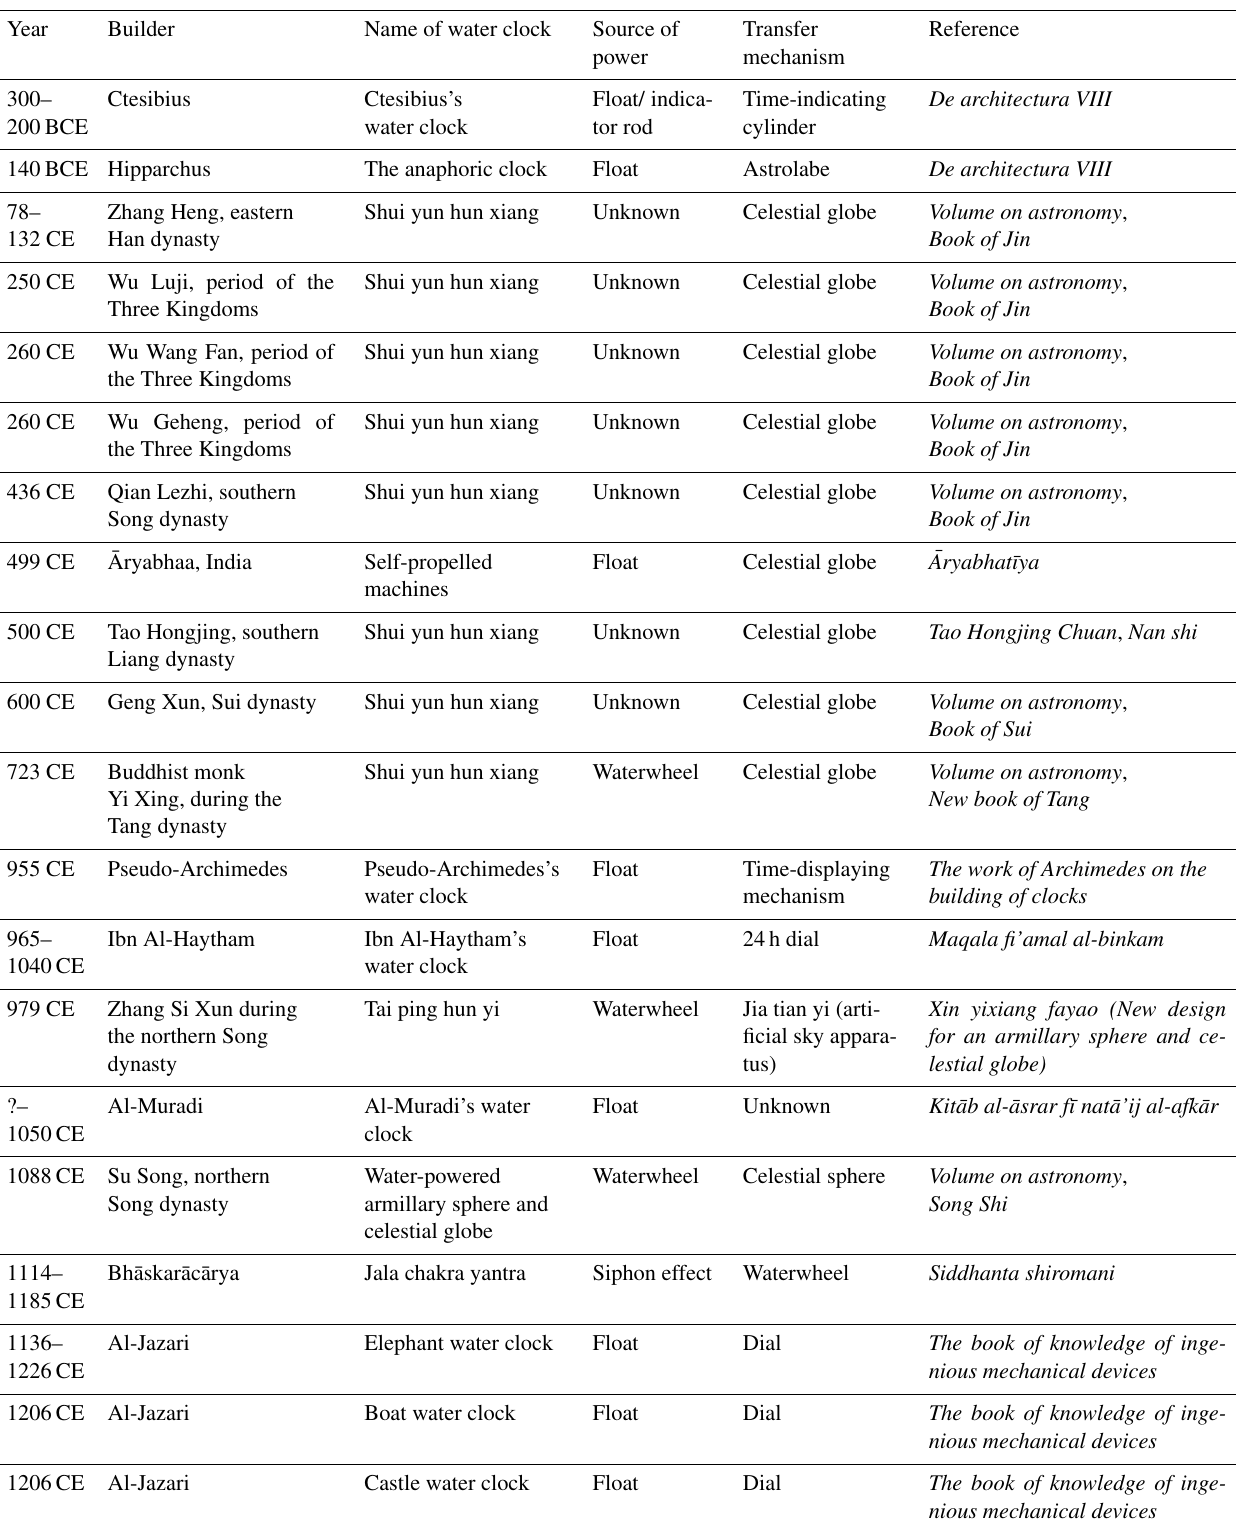
Table 1. Power transmission systems of water-powered mechanical